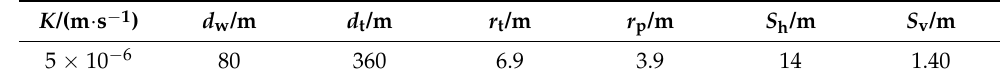
Figure 7. Cross-section of the proposed Jiajiaoshan Tunnel and parallel adit. Table 1. Calculation parameters.